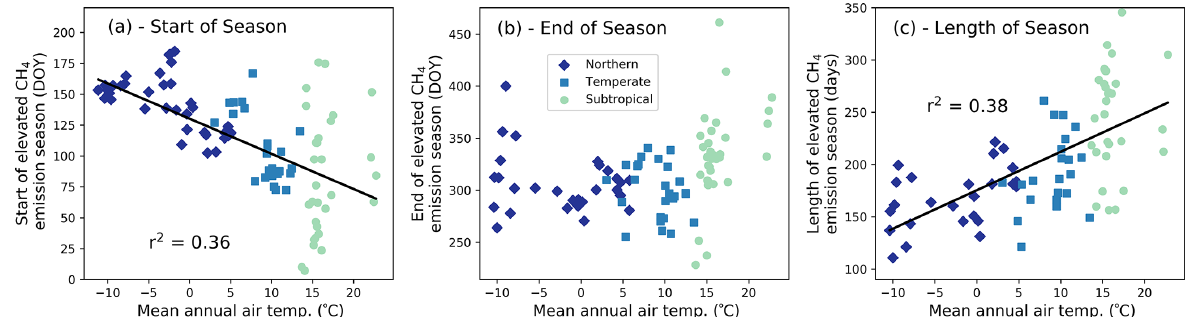
Figure 10. The (a) start of the elevated methane (CH 4 ) emission season ( y = -2 . 8 x + 130, with “ x ” in ◦ C and “ y ” in day of year, DOY), (b) the end of the elevated emission season in DOY, and (c) the length of the emission season with mean annual site air temperature ( y = 3 . 6 x + 176 . 6, with “ x ” in ◦ C and “ y ” in days). Each point represents a site year of data, and all reported r 2 values are significant to p < 0.0001. Tropical sites are discussed separately in Sect. 3.3.3.